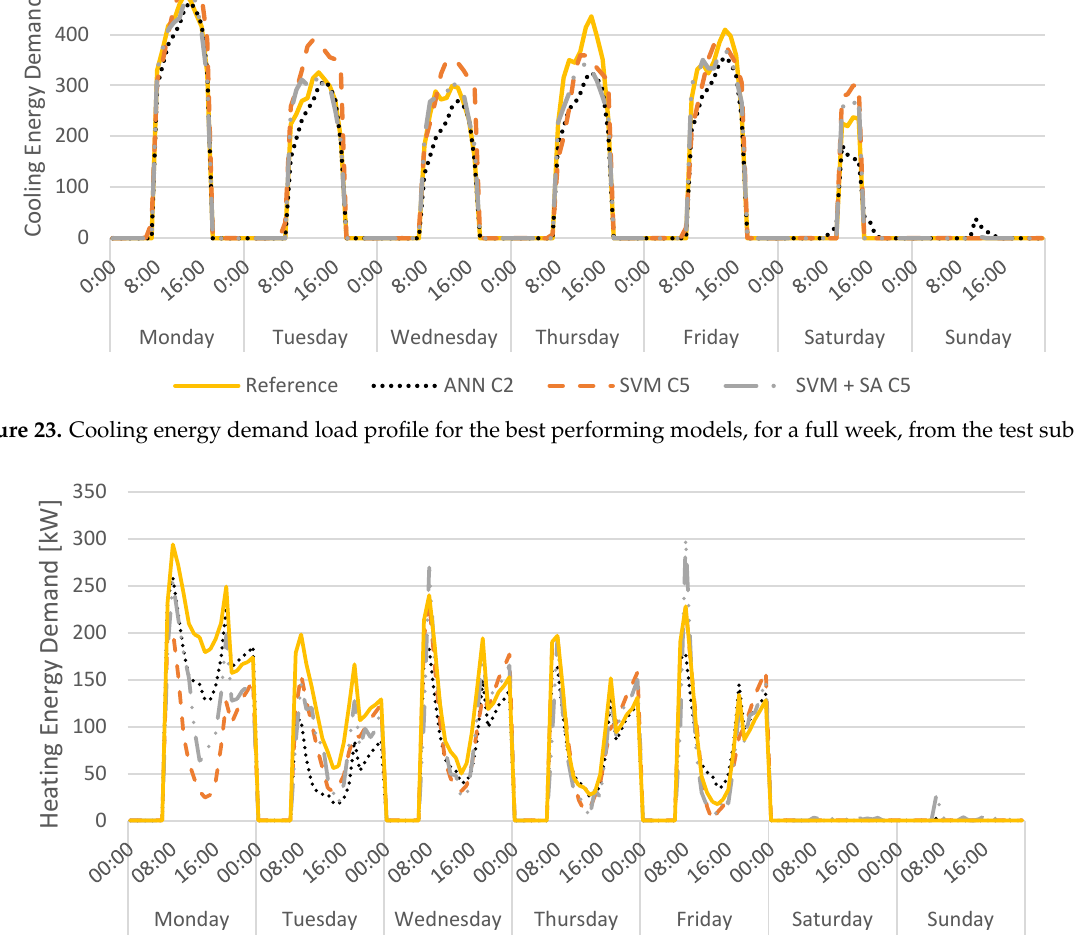
Figure 24. Heating energy demand load profile for the best performing models, for a full week, from the test subset.